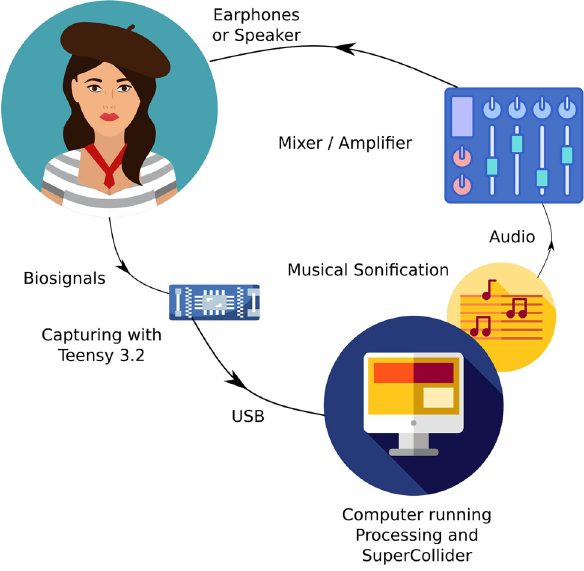
Figure 25: Prototype arrangement for soni fi cation of